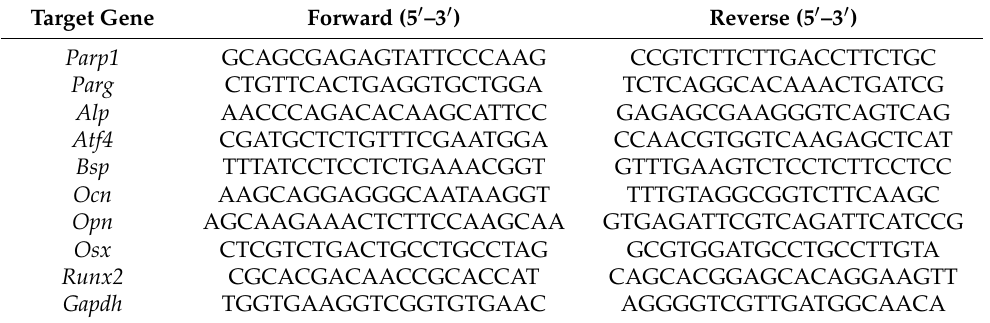
Table 1. Primers for